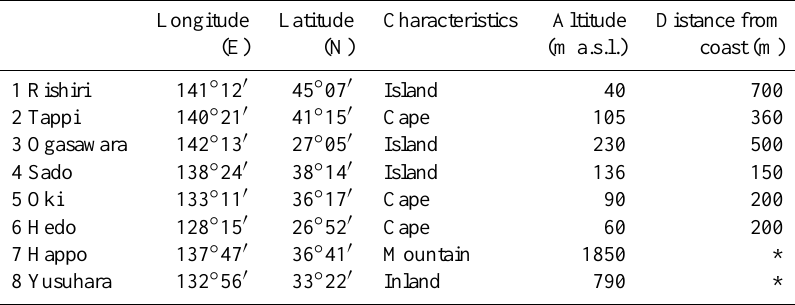
Table 1. Location information for the eight EANET remote observation sites in Japan used in the study. The station locations are also shown in Fig. 3.